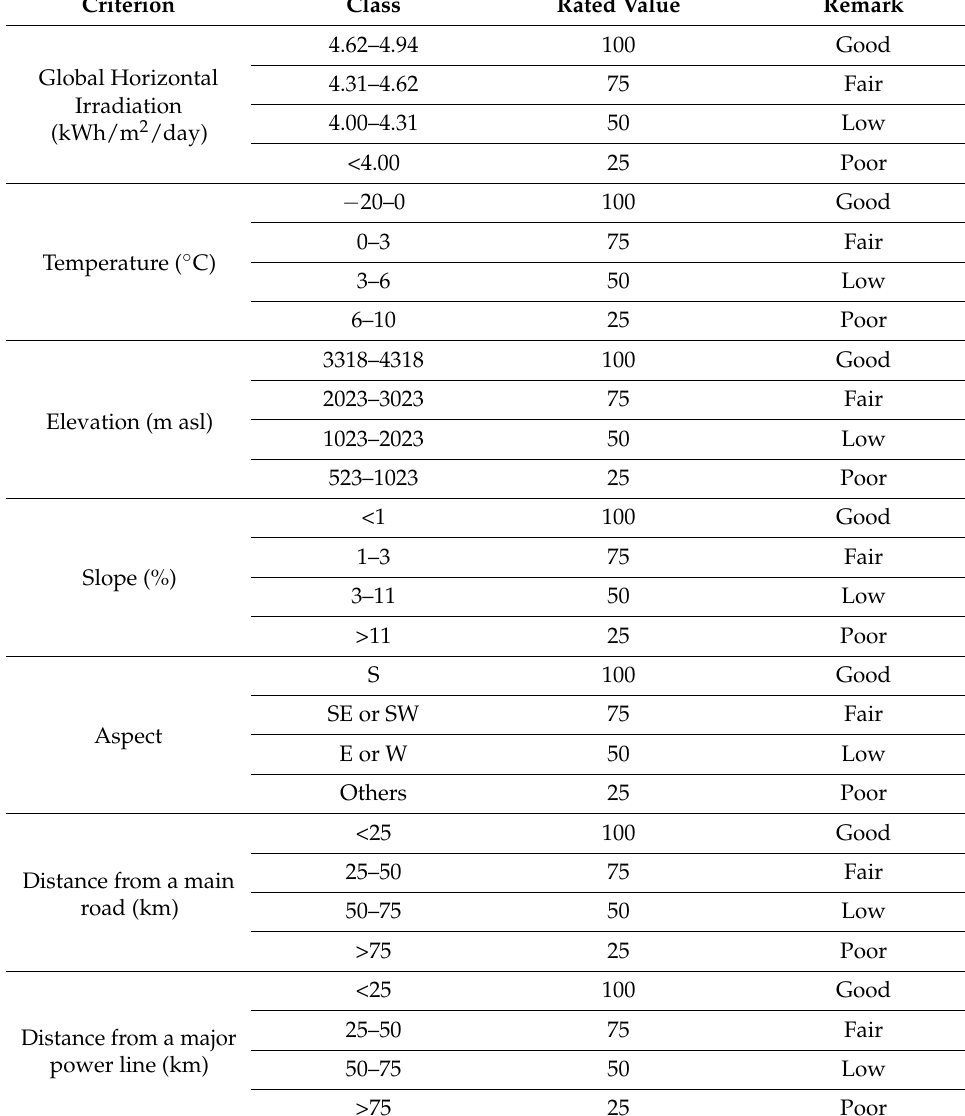
Table 3. Rating criteria used in this